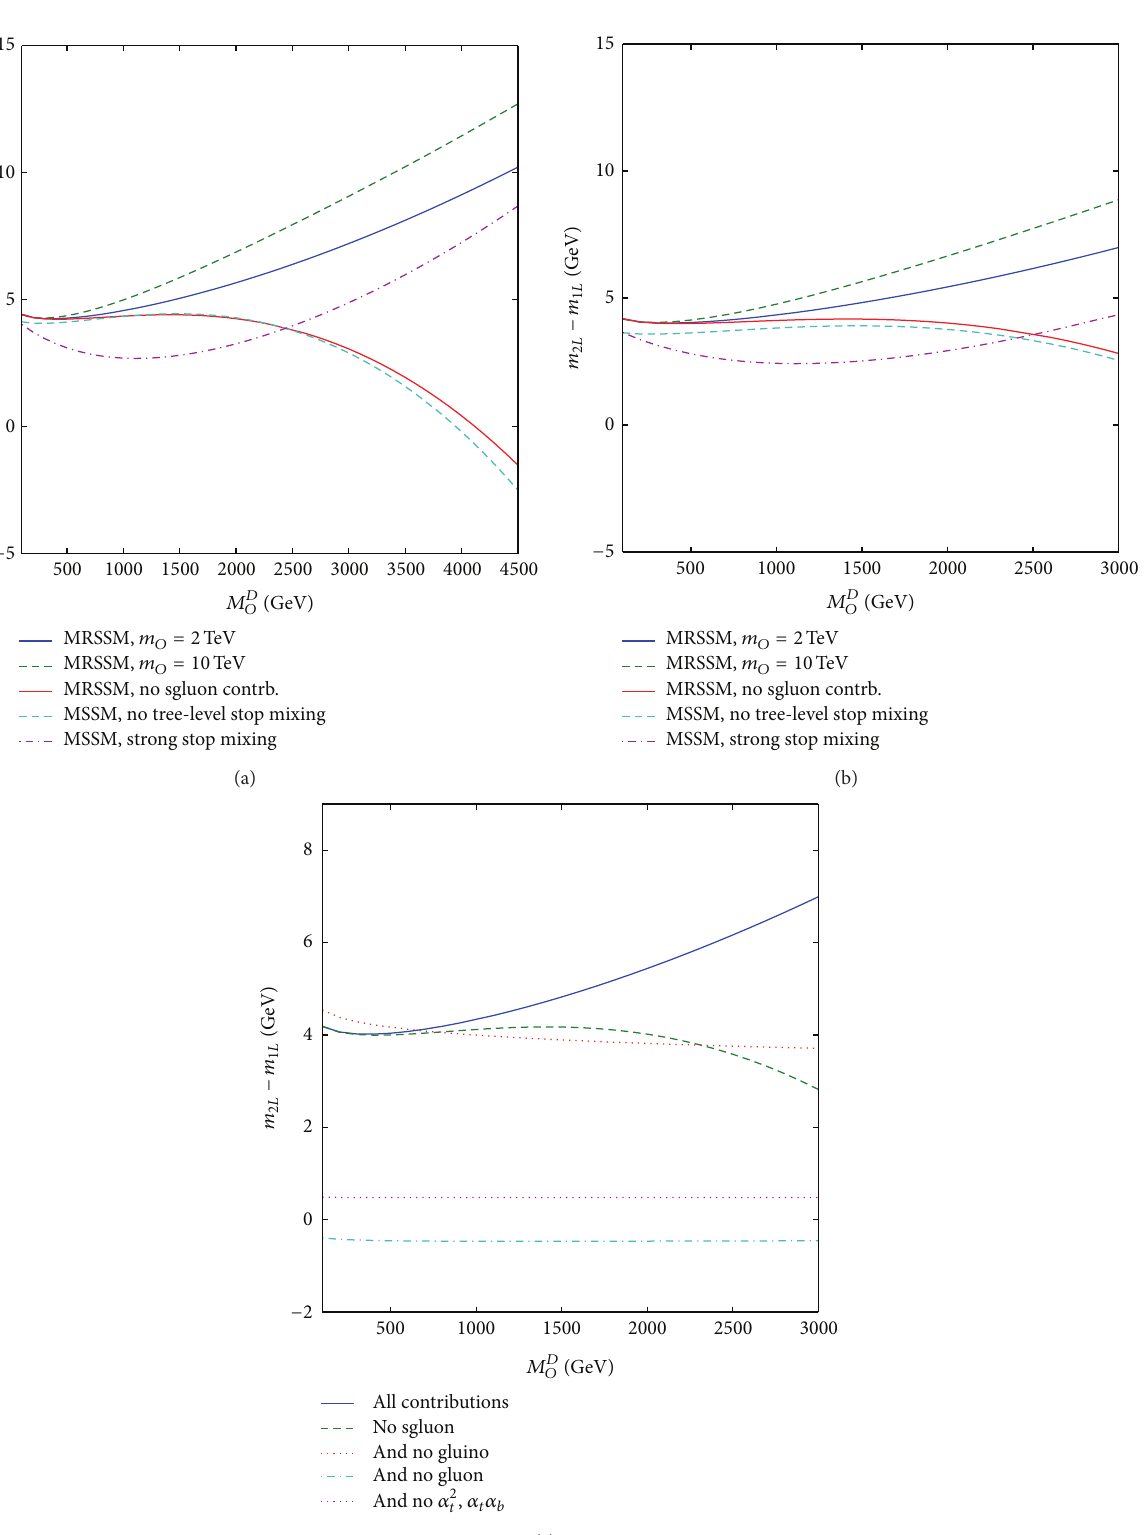
Figure 5: Two-loop contributions to the SM-like Higgs boson mass depending on the gluino mass in the MRSSM for BMP1 (a) and BMP3 (b) and two different values of the soft sgluon mass parameter 𝑚 𝑂 = 2TeV (thick solid blue line) and 10 TeV (thick dashed green line) with all contributions, respectively, and without the sgluon contributions (thin solid red line). For comparison also the MSSM contributions for no (thin dashed light blue line) and maximal (purple dotted line) stop mixing are plotted. The chosen MSSM parameters are given in Table 1. For BMP3 and 𝑚 𝑂 = 2TeV (c) shows the result, when successively switching off dominating and subdominating